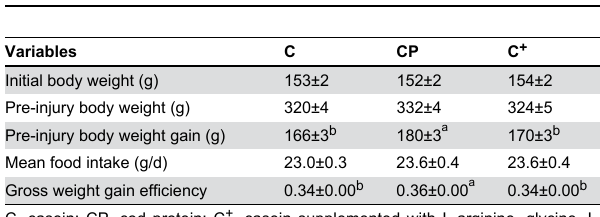
Table 2. Pre-injury body weight and food intake of rats fed purified diets for 21